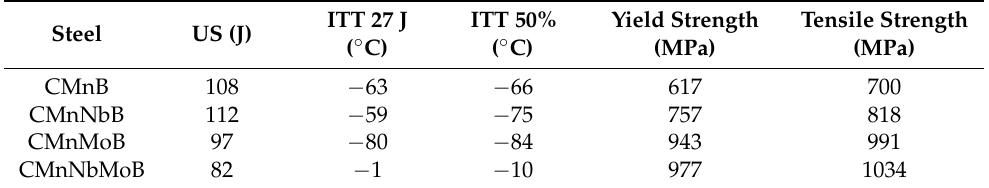
Table 2. US (Upper-Shelf Energy), ITT27J, ITT50%, yield strength and tensile strength values mea- sured from Charpy and tensile